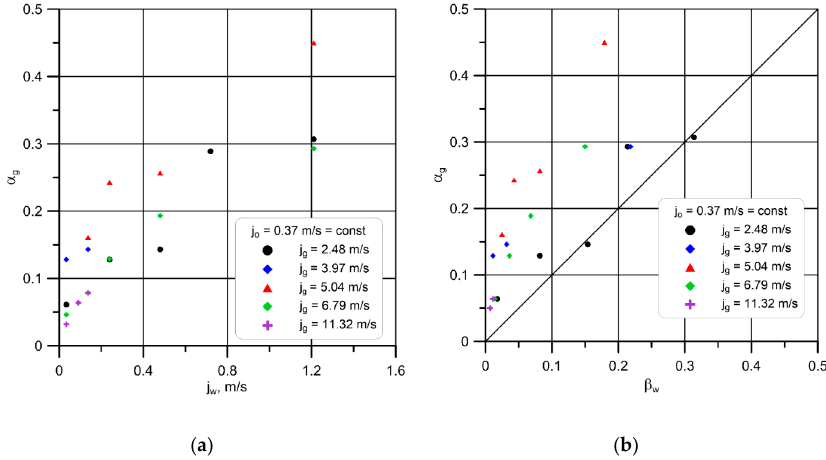
Figure 6. Example applied to illustrate the relation between water volume fraction, α w , for oil viscosity of η o = 0.3 Pas on ( a ) the value of superficial water velocity, j w , and ( b ) the value of the water volume fraction at the channel inlet, β w .